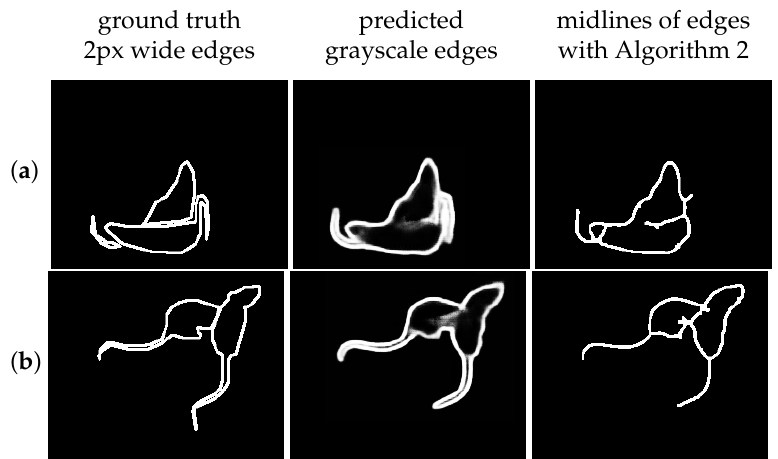
Figure 11. Illustration for the edge measurements. The F-score of the predicted grayscale edges in ( a ) (F = 0.6069) is better than the F-score of ( b ) (F = 0.5610). The predicted edges for ( b ) are distorted, but the extracted midline allows segmentation for both instances separately, as described in Algorithm